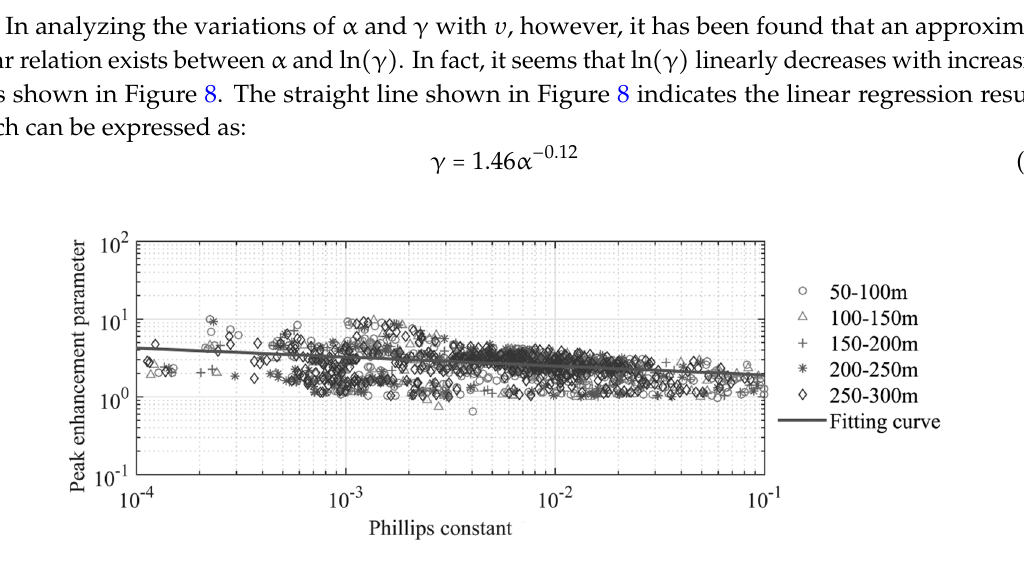
Figure 8. Values of ln(γ) as a function of α .